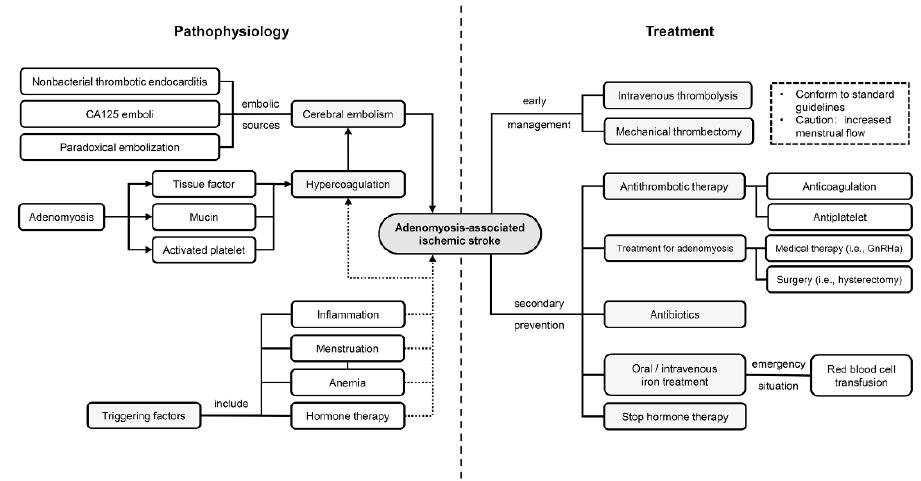
Figure 1. Underlying pathophysiology and treatment strategies in adenomyosis-associated ischemic stroke. A hypercoagulation state, potentially caused by excessive tissue factor and mucinous protein and activated platelets, leads to cerebral embolism. Several factors, such as menstruation and inflammation, may trigger the pathophysiological process. Management strategies mainly consist of antithrombotic therapy and treatments targeting adenomyosis. Abbreviation: CA125: carbohydrate antigen 125; GnRHa: gonadotropin releasing hormone analogs.